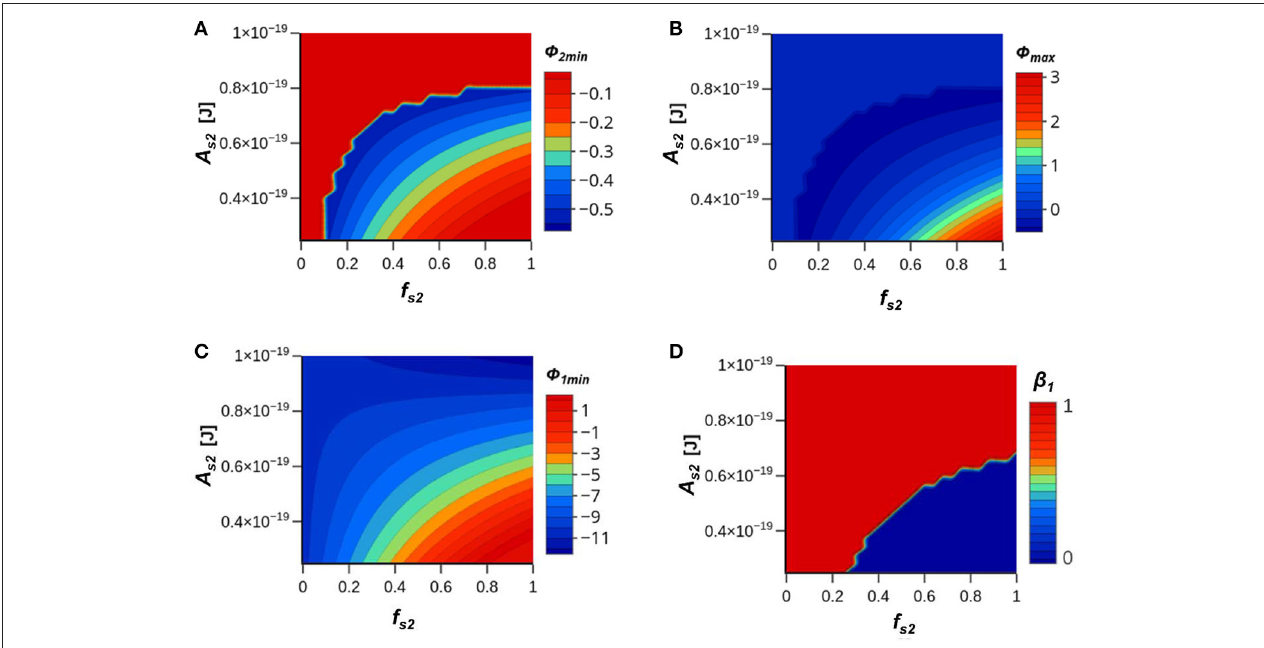
100mM NaCl, the bacteria ( f cr =